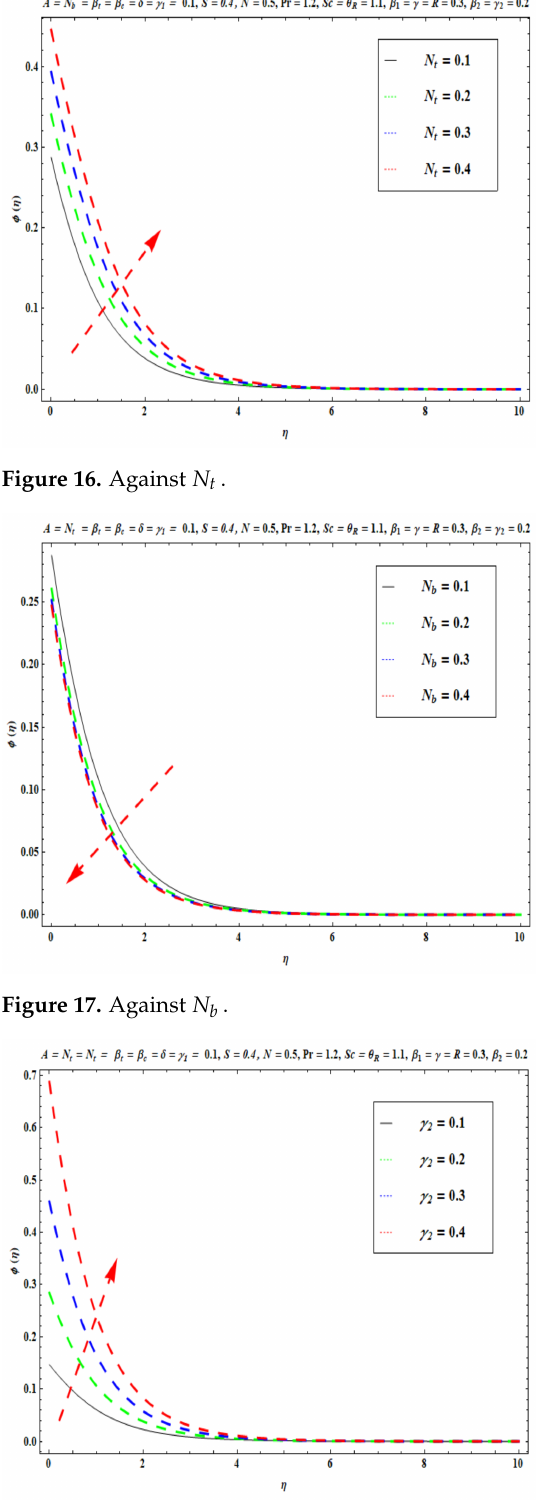
Figure 18. Against γ 2